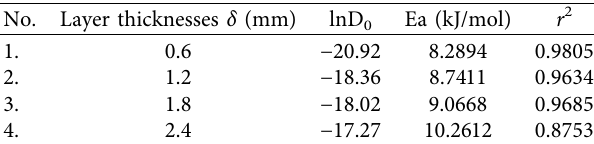
Table 4: The values of the kinetic parameters of the spent coffee grounds drying process.